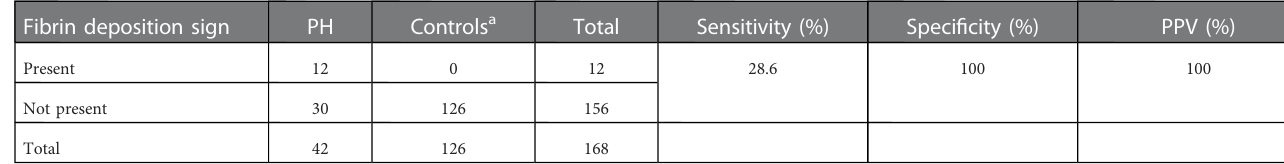
TABLE 4 The sensitivity and speci fi city of fi brin deposition sign for PH diagnosis. Fibrin deposition sign